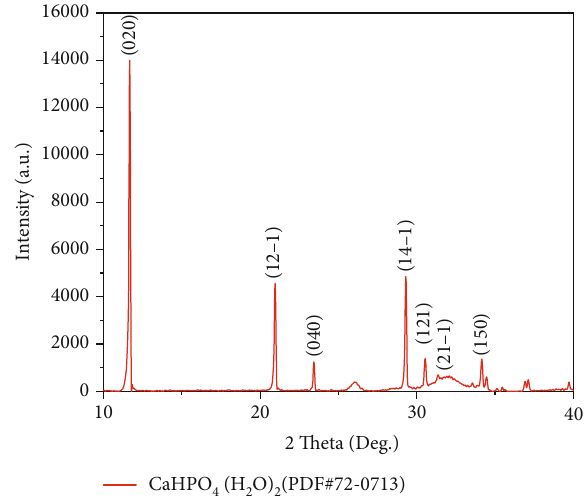
Figure 1: XRD analysis of the precipitation by adding inorganic phosphorus salt to Ca 2+ -rich